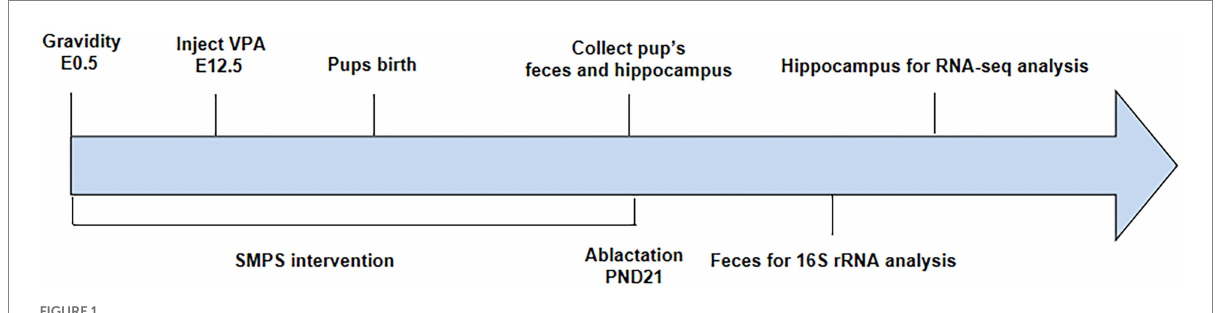
FIGURE 1 Schematic representation of the experimental